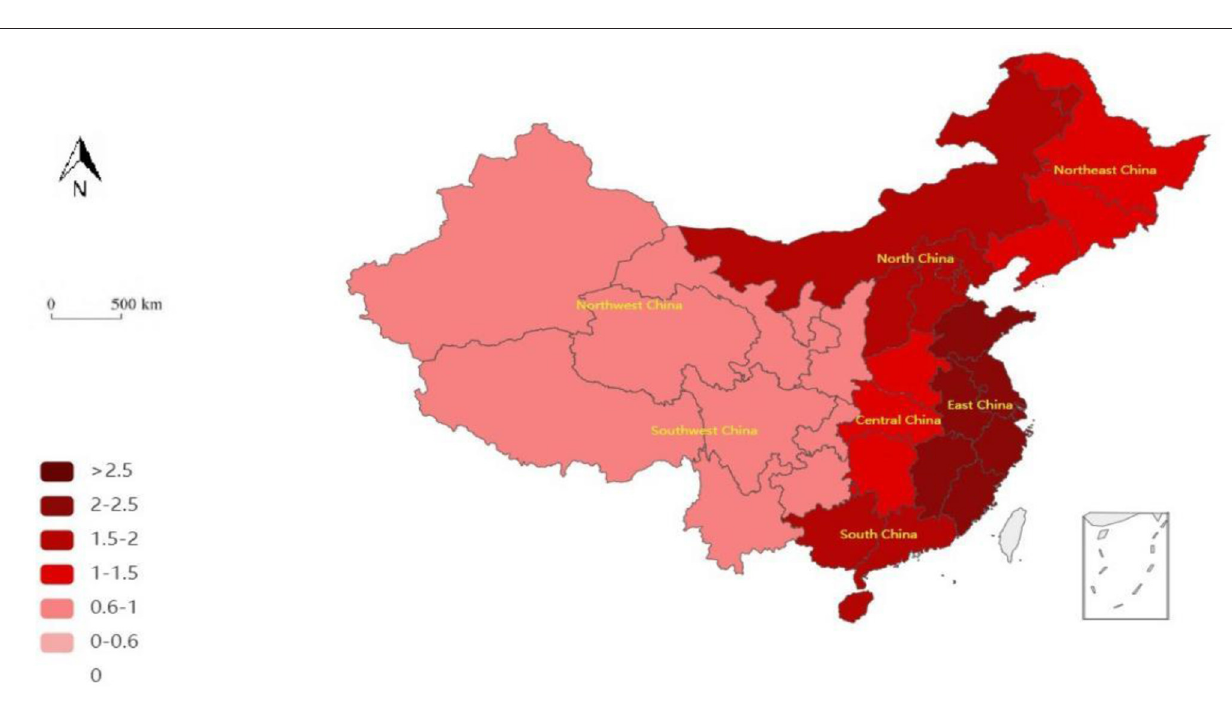
pollution was smaller than that of efficiency. With